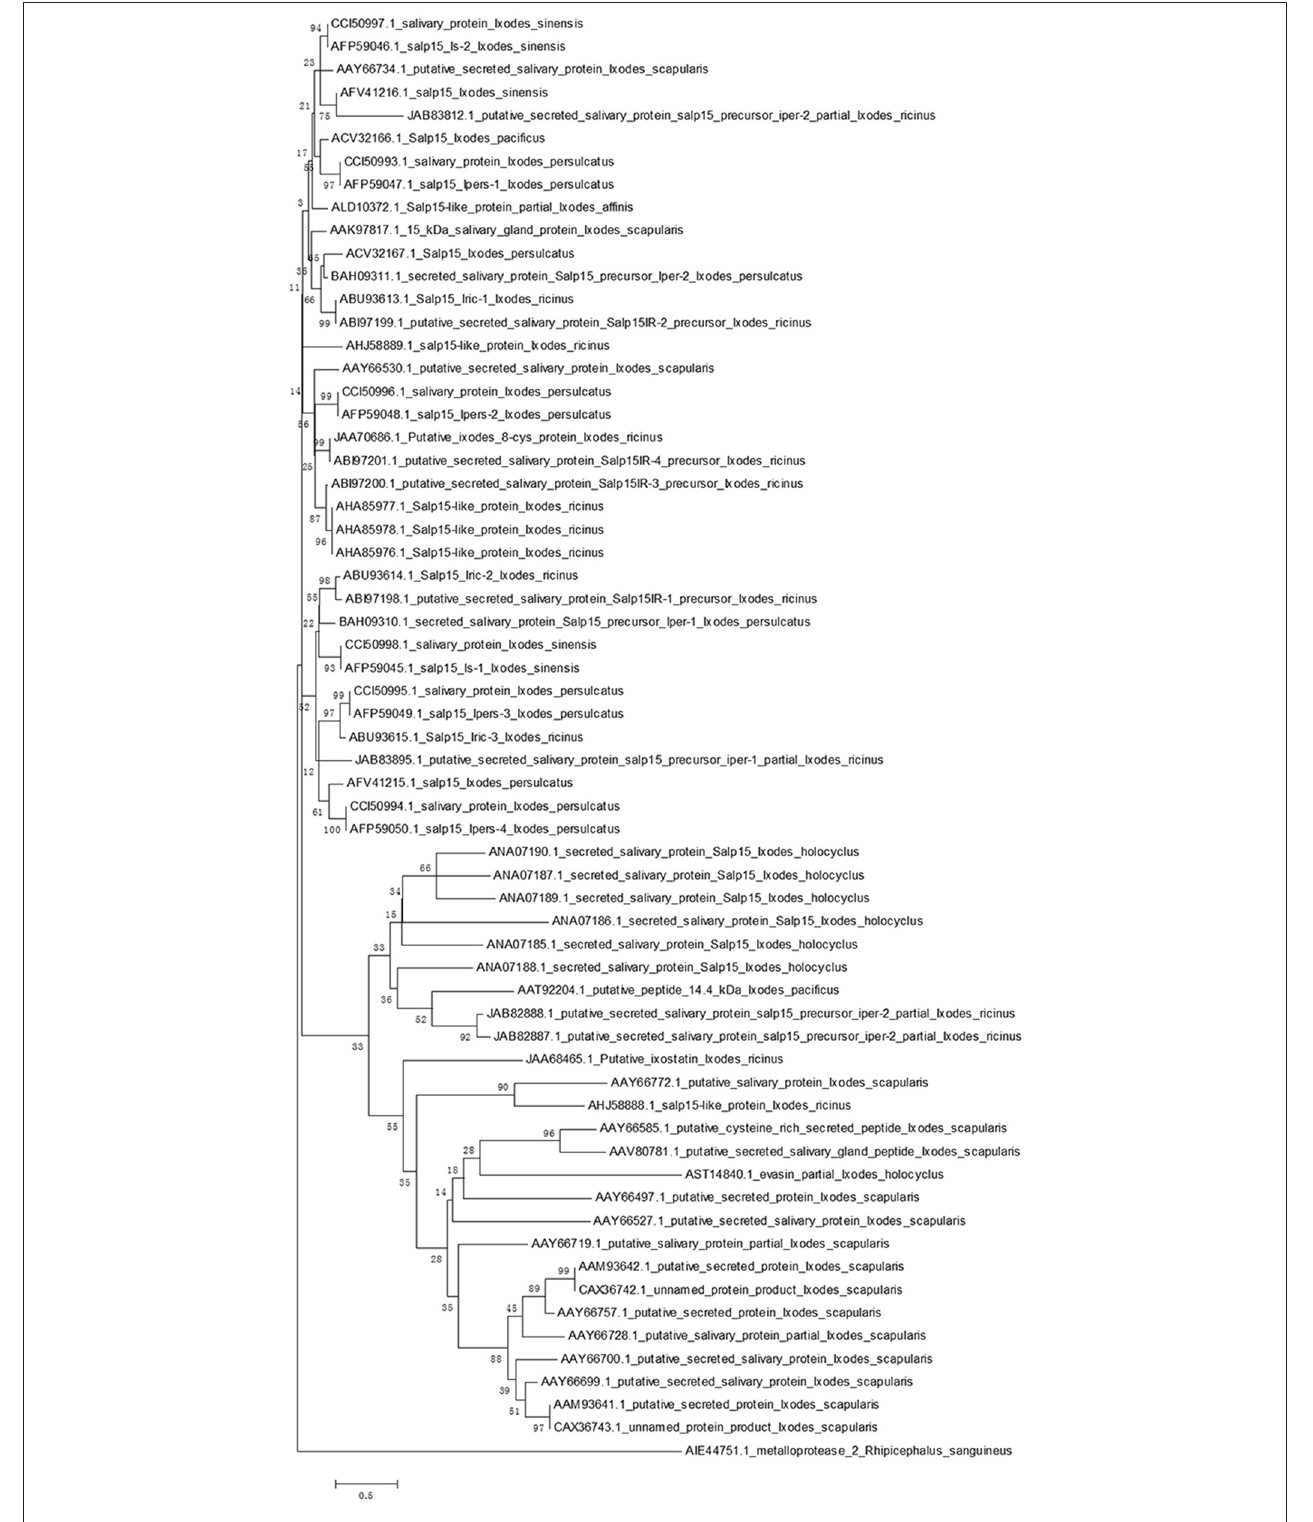
FIGURE 1 | Phylogenetic analysis of Salp15 protein family. A phylogenetic tree of Salp15 homologs was generated using amino acid sequences from I. scapularis , I. pacificus , I. ricinus , I. persulcatus , I. holocyclus , and I. sinensis . Accession numbers for the sequences are shown. Sequences were aligned using ClustalW software online, and the phylogenetic tree was constructed using MEGA 5 software.